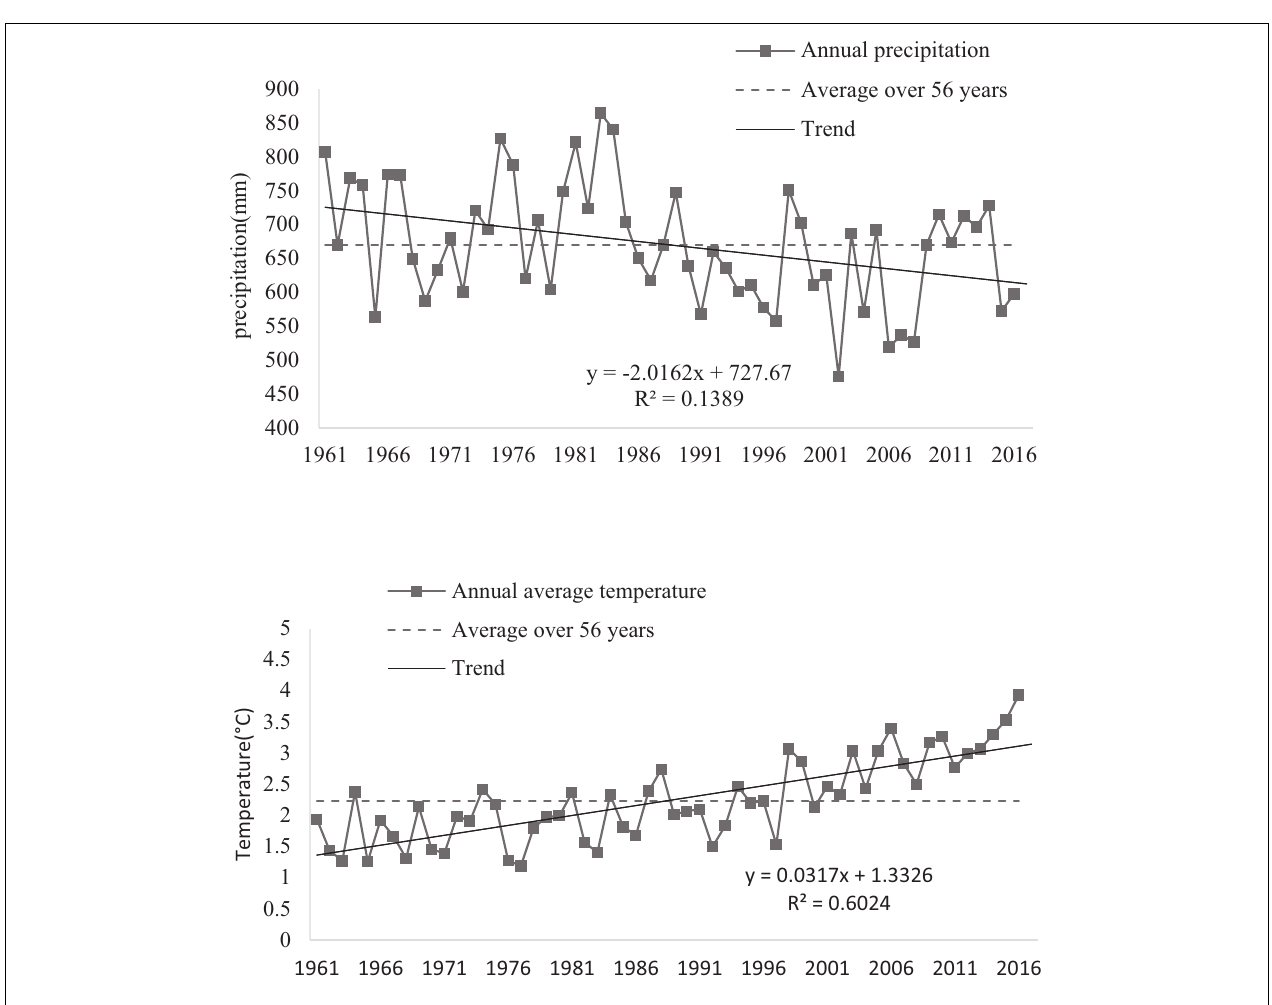
FIGURE 3 | Trends in temperature and precipitation in the SYRS from 1961 to 2016.